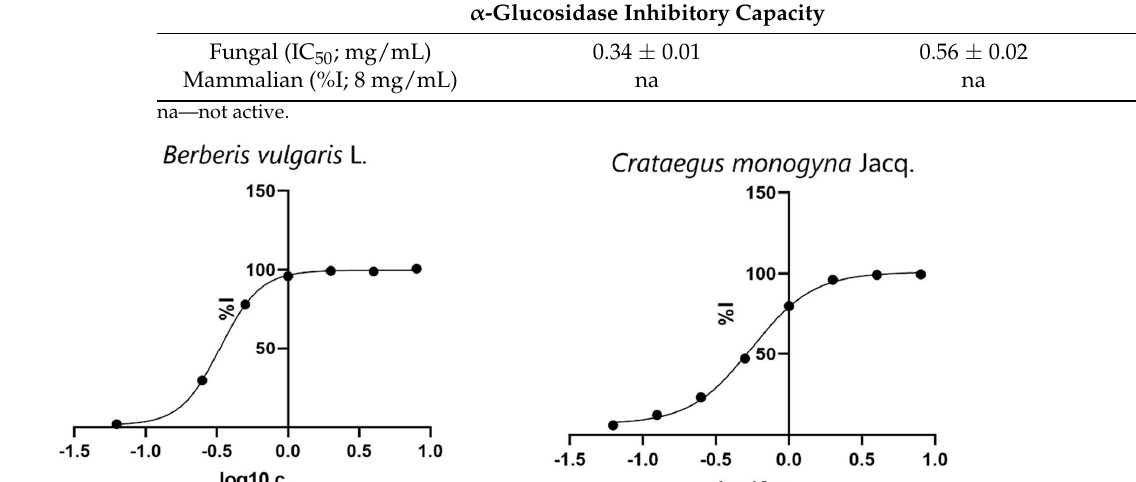
Figure 5. Graphic representation of logarithm of extract concentration (log 10 [c]) versus the percent of enzyme inhibition (%I) of B. vulgaris ( A ) and C. monogyna ( B ) extracts. Hajzadeh et al. have shown that the maceration of Berberis fruits for 3 h followed by extraction did not have any effect on the lipidic profile of studied animals. Barberry extracts with a concentration of 3.5% and 7.5%, administered for six weeks, presented no hypoglycemic or hypolipidemic effects in rats with streptozotocin induced diabetes [65]. Some in vivo studies have demonstrated that barberry fruit extract has no effect on glucose profile. However, studies have reported inconsistent data. Some researchers have mentioned a beneficial effect of B. vulgaris against diabetes and its subsequent pathophysiological effects [65,66]. Moreover, following the beneficial effect of barberry on diabetic markers, researchers were interested in studying the mechanisms by which fruits exert their antidiabetic effect. Two clinical studies identified potential explanations for the aforementioned effect. The first stated that a barberry extract obtained by fruit infusion has a beneficial effect on lipoprotein and apoprotein levels and could control glycemic levels of patients [67]. The second stated that barberry fruit extract could improve glucose catabolism (by supporting aerobe glycolysis), insulin secretion, and its action, but that it may also act on glucose absorption [68]. 4. Conclusions The drying of medicinal edible plant materials is a process that consists of various physical, chemical, and biological phenomena. It is very important to understand them in order to achieve high yields of bioactive compounds. In this paper, the drying process of two edible fruits traditionally used as remedies in Romania (i.e., B. vulgaris and C. monogyna ) was optimized using an experimental design. It was found that the optimal time for drying B. vulgaris fruits at 60 °C was 14.32 h, whereas that for C. monogyna fruits at the same temperature was 16.14 h. Furthermore, the extracts obtained by applying optimal drying conditions yielded high antioxidant activity (barberry fruits—50.85, 30.98, and 302.45 mg TE/g dw for DPPH, TEAC, and FRAP assays, respectively). Moreover, B. vulgaris and C. monogyna extracts exhibited outstanding α‐ glucosidase inhibitory activity (IC 50 = 0.34 and 0.56 mg/mL, respectively). In the light of these results, the main bioactive